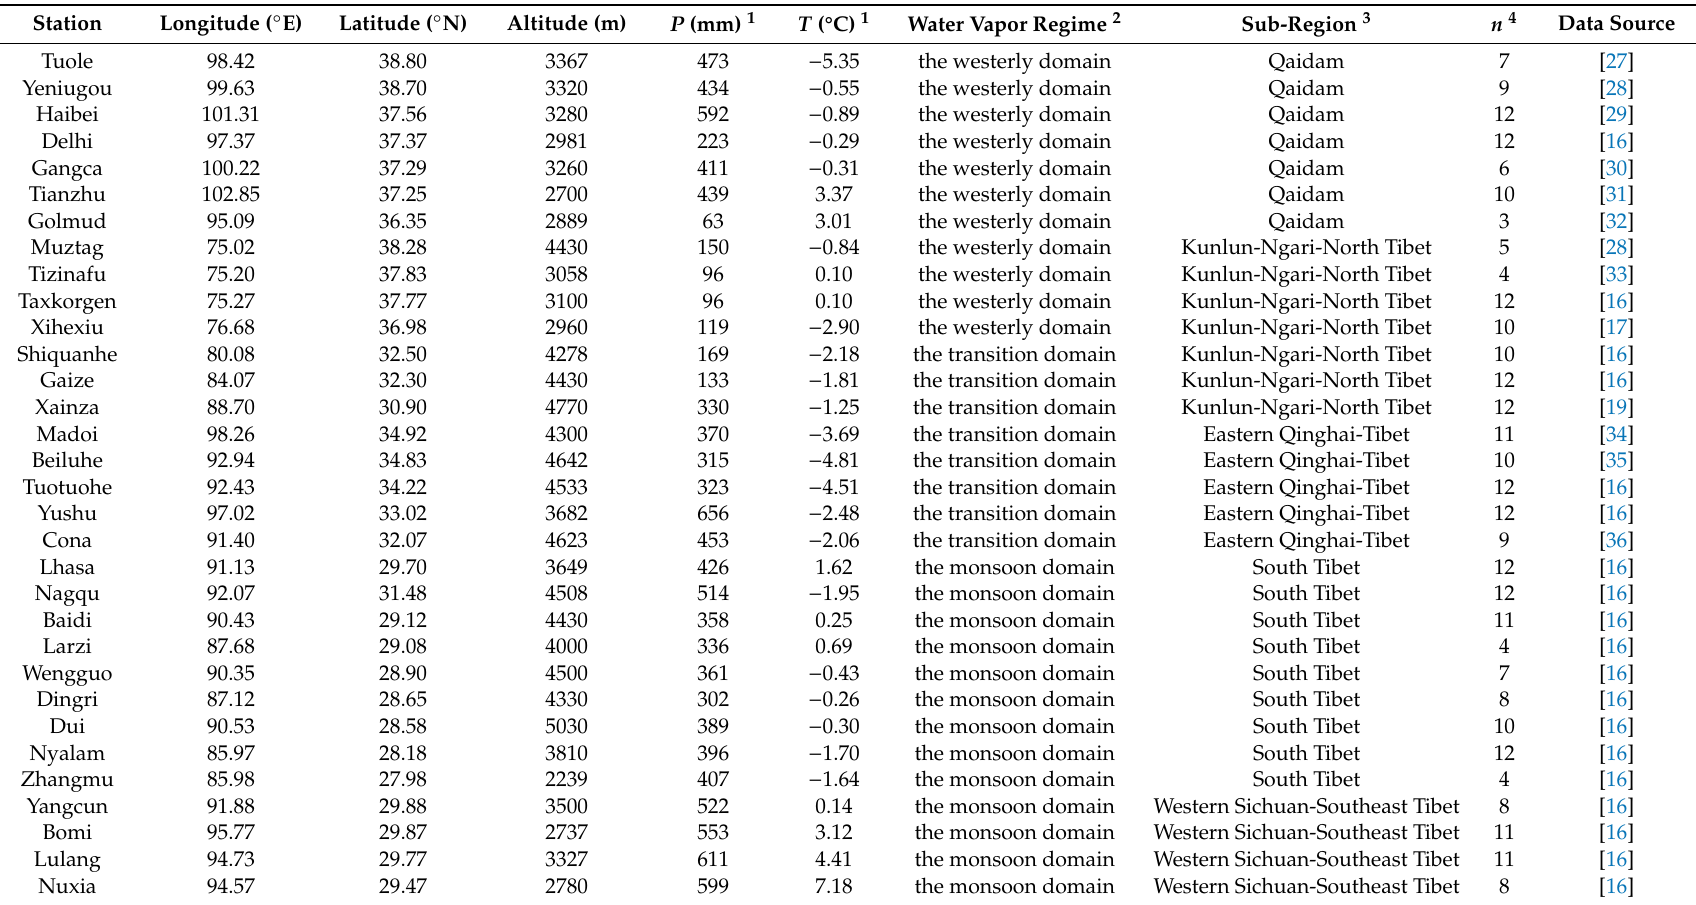
Table 1. Basic information and long-term climatology for each sampling station across the Qinghai-Tibet